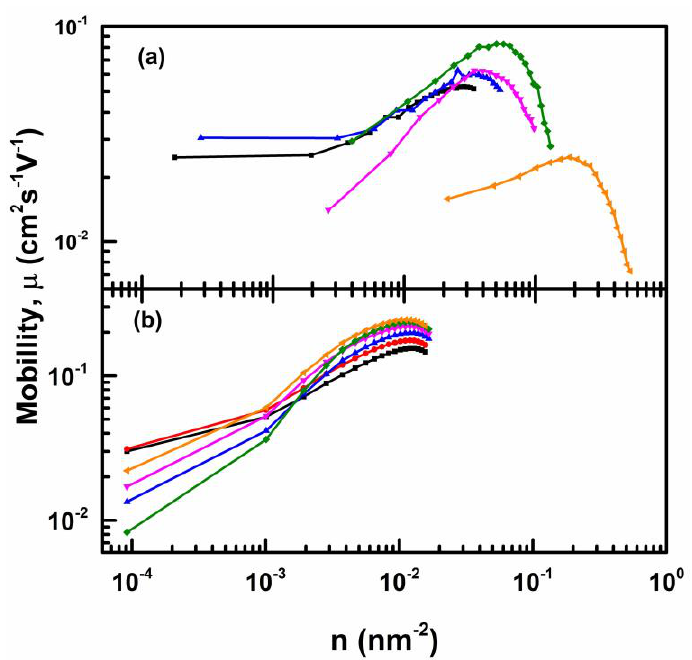
Figure 7. The dependence of the hole mobility on the surface charge concentration in the TIPS-P layer deposited on top of ( a ) CEPVA50 and ( b ) PVPCL for various temperatures: 10 °C (black), 20 °C (red), 30 °C (blue), 40 °C (pink), 50 °C (green) and 60 °C (orange).